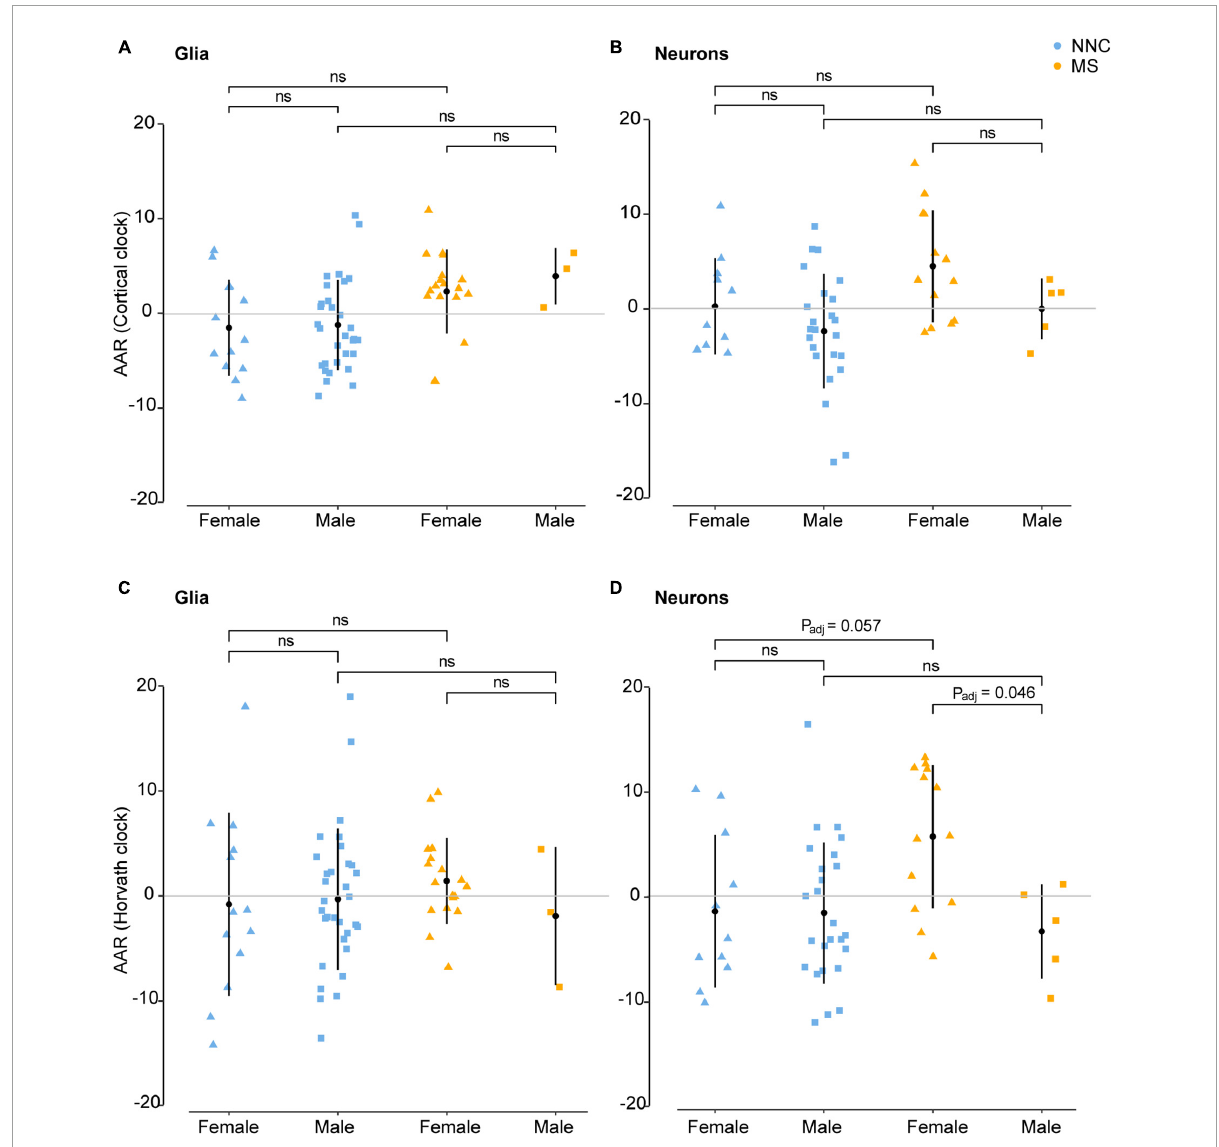
FIGURE4 Age acceleration in glia and neurons of MS patients and controls stratified according to sex. Age acceleration residuals (AAR) in glial cells [left panels (A,C) ] and neurons [right panels (B,D) ] of female and male MS patients and controls were estimated using the Cortical clock [upper panels (A,B) ] and Horvath’s clock (C,D). No significant sex difference was found in bulk brain tissue with neither of the two clocks. Normality was tested with the Shapiro–Wilk test. Equal variances were tested with Bartlett’s test. Sample means were compared with a Tukey HSD test, correcting P-values for multiple testing with the single-step method. Adjustment refers to PMI, replicate status, and PC1 (only for glia cohort). F, female; M, male; MS, multiple sclerosis; NNC, non-neurological controls; ns, not significant. Data were retrieved from Kozlenkov et al. (2014), Gasparoni et al. (2018), and Kular et al. (2019,